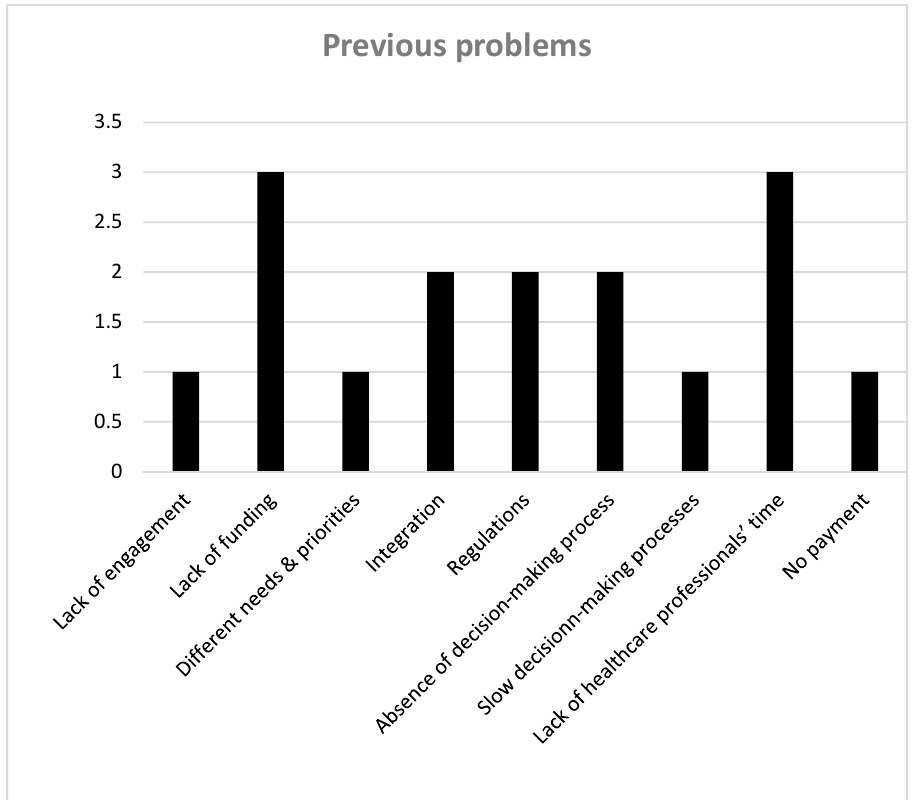
Figure 3. Previous company challenges related to the hospital innovation.